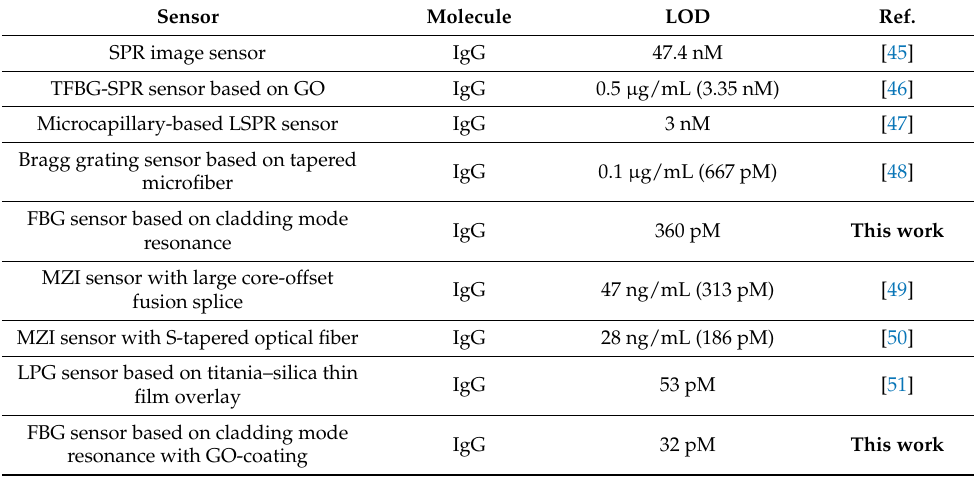
Table 1. Comparison of the label-free optical fiber sensors for IgG